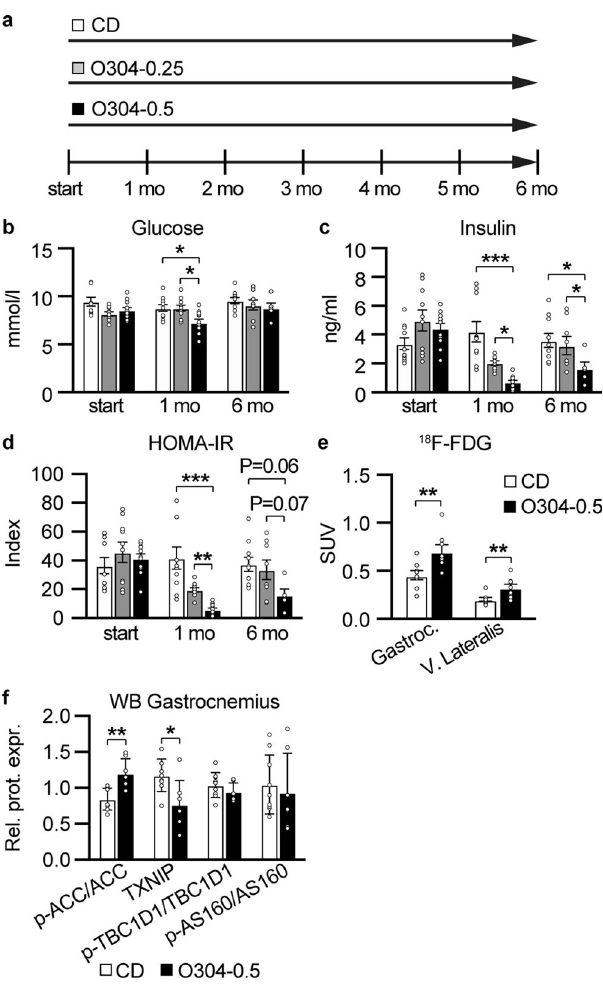
Fig. 3 O304 ameliorates hyperinsulinemia and insulin resistance in